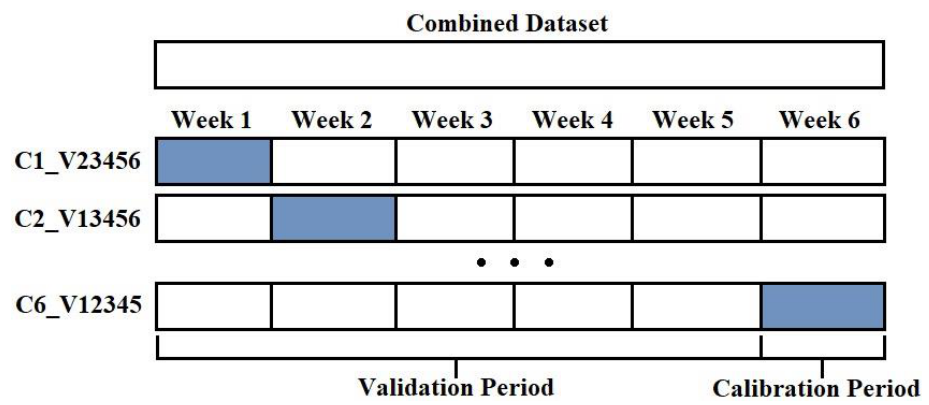
Figure 4. Folded data configurations for validation and calibration periods (C1V5). Table 4. Accuracy of models calibrated on one week of data. The values in bold indicate the accuracy of the training week. The corresponding line plots for these bold values are in Figure